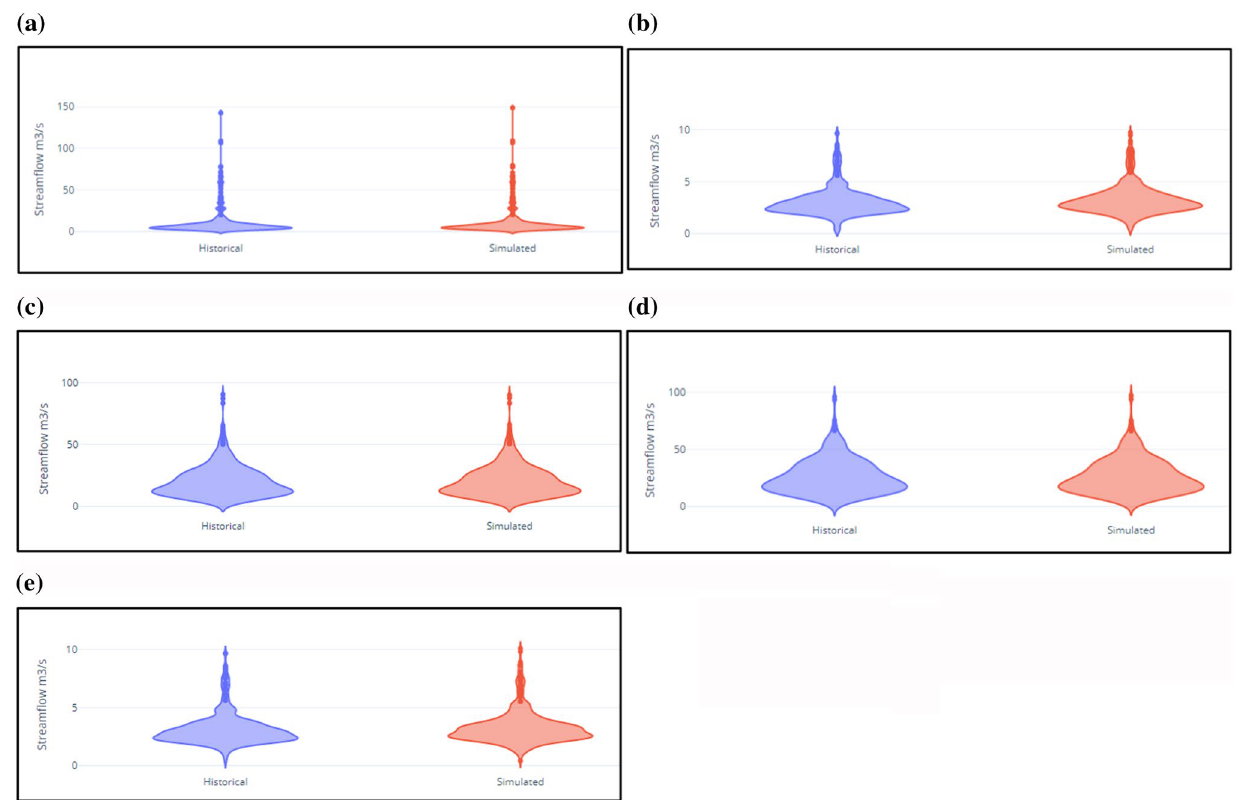
Fig. 10 Violin plot for all study areas: a study area D, b study area A, c study area B, d study area C, and e study area